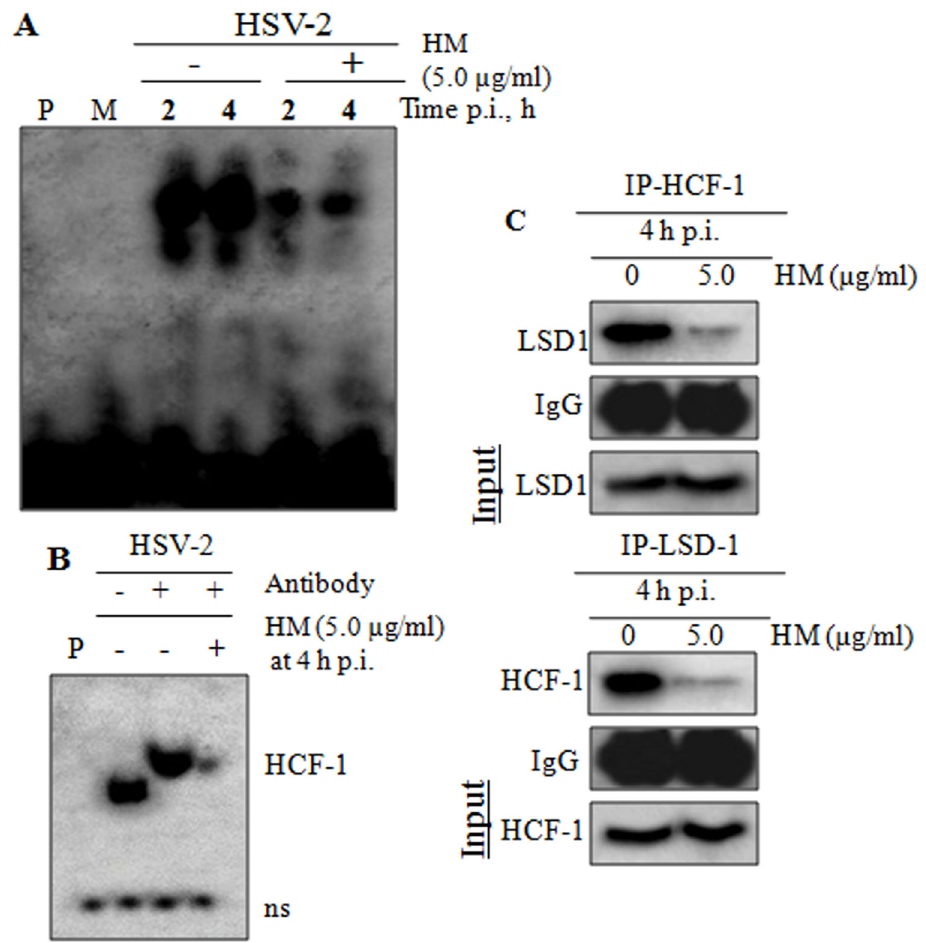
Figure 5. Effect of HM on viral IE transcriptional events. [A] EMSA : HSV-2G infected Vero cells were treated with HM for 2 and 4 h and assayed for EMSA. Biotin-labelled oligo was present in Lanes 1-6; P, biotin labelled oligo, M, mock control. [B] Supershift assay : nuclear extracts from HSV-2G infected HM treated cells for 4 h p.i. was pre-incubated with HCF-1 polyclonal antibodies, added with reaction mixture, applied to non-denaturing 4% polyacrylamide gels and visualized by autoradiography. P, free biotin labelled probe; ns, nonspecific binding. [C] HCF-1 or LSD1 were immunoprecipitated in HM treated virus infected Vero cell lysate and the association was confirmed by immunoblotting with anti-HCF-1 and anti-LSD1 antibodies.